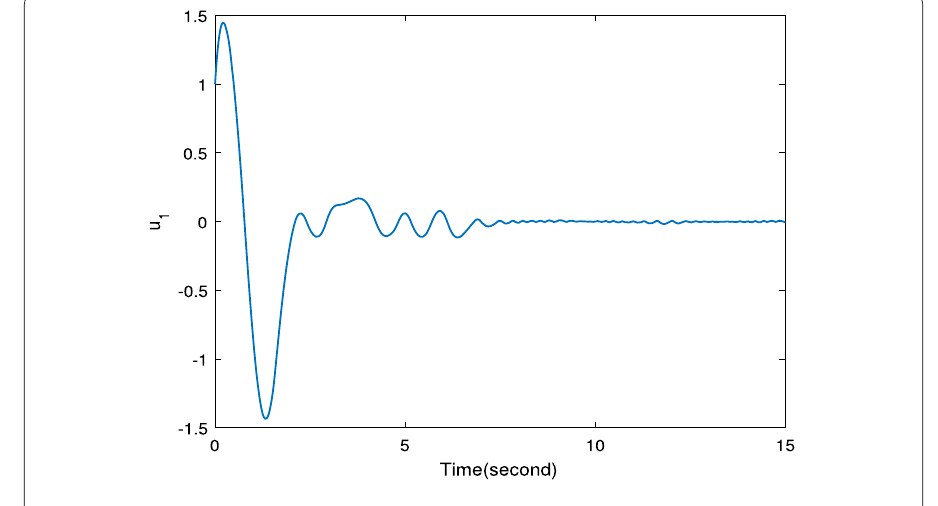
Figure 5 Time response of state variables of u 1